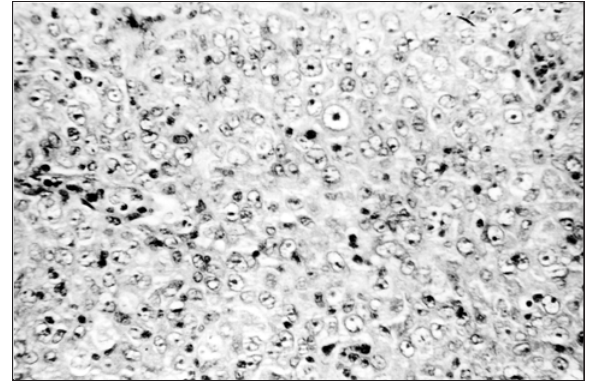
Figura 6 – Linfoma T periférico: linfócitos pleomórficos de tamanho pequeno, médio e grande associados a proliferação de vasos sangüíneos